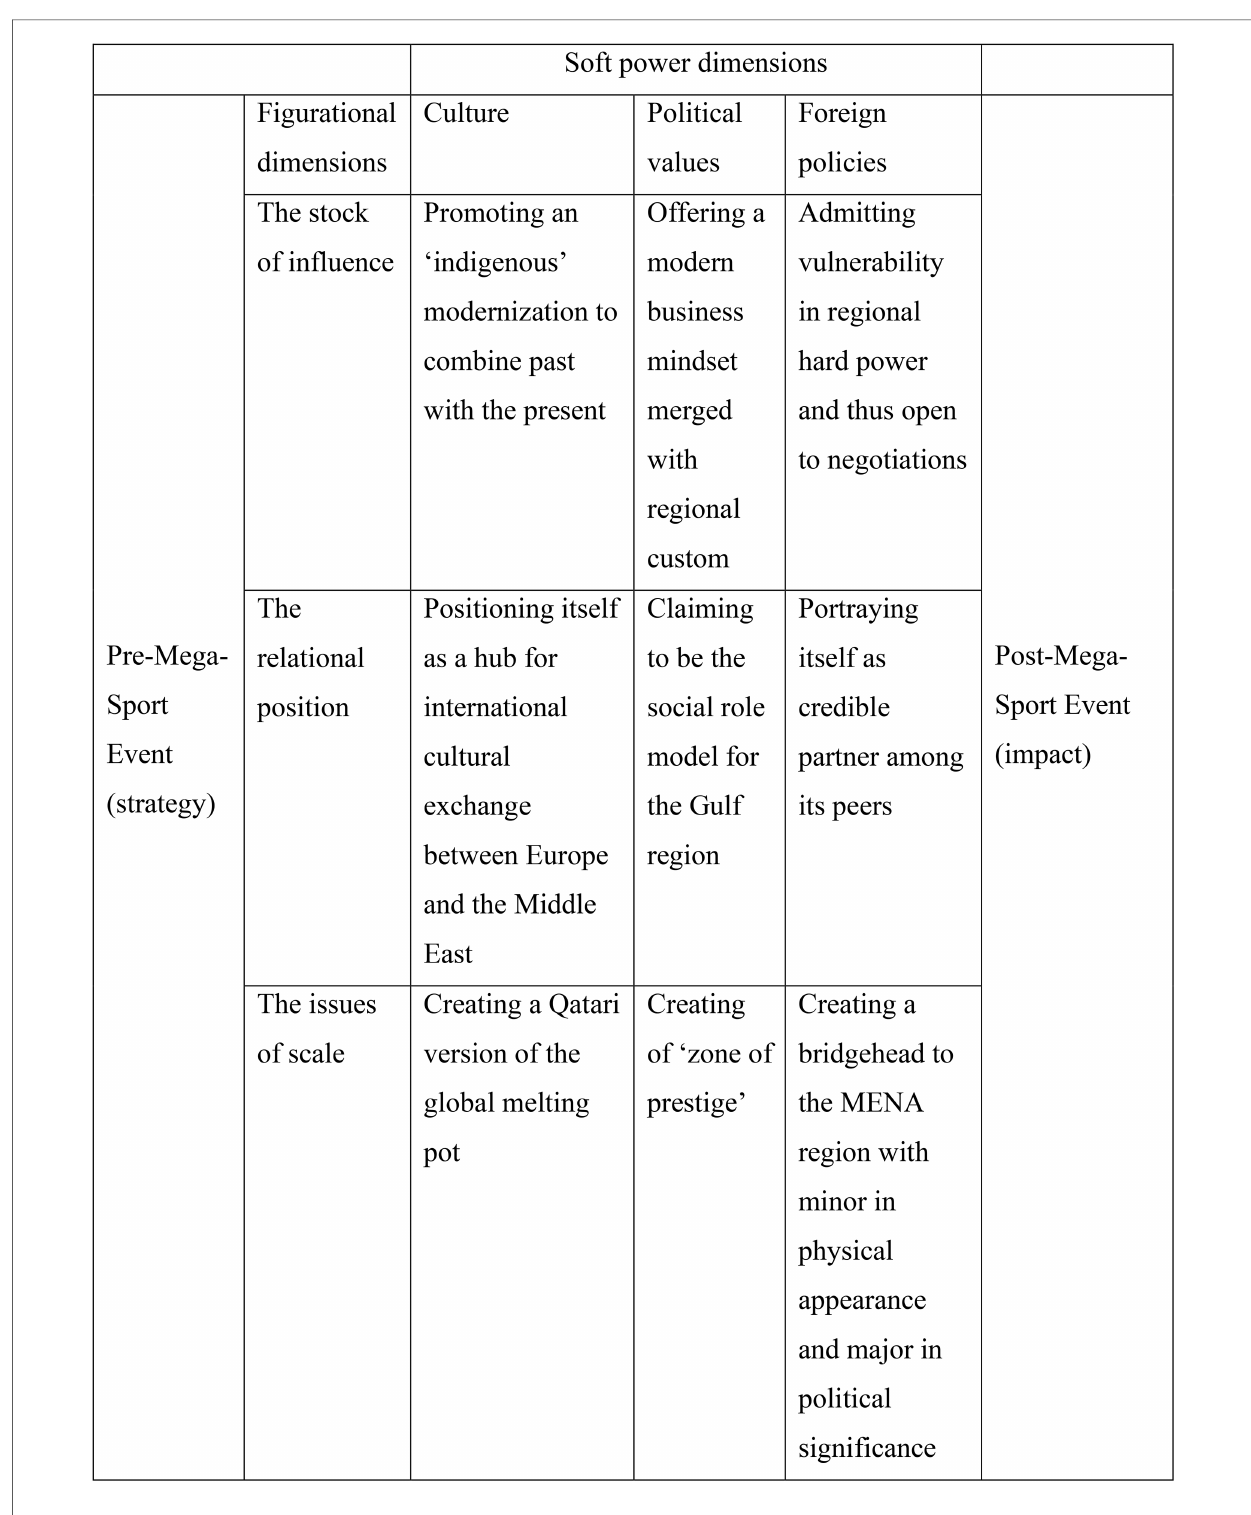
FIGURE 1 An eliasian approach to soft power and sport using the FIFA World Cup Qatar 2022 TM as